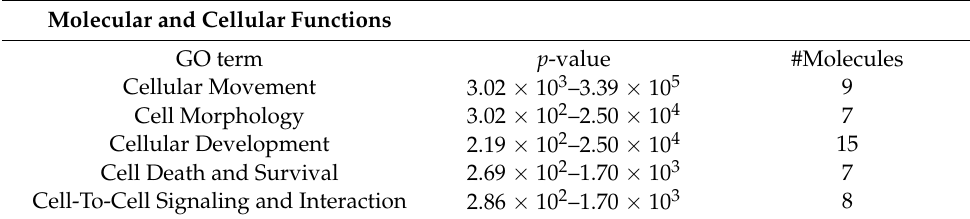
Table 2. Gene ontology analysis of extracted upregulated genes. Molecular and Cellular Functions